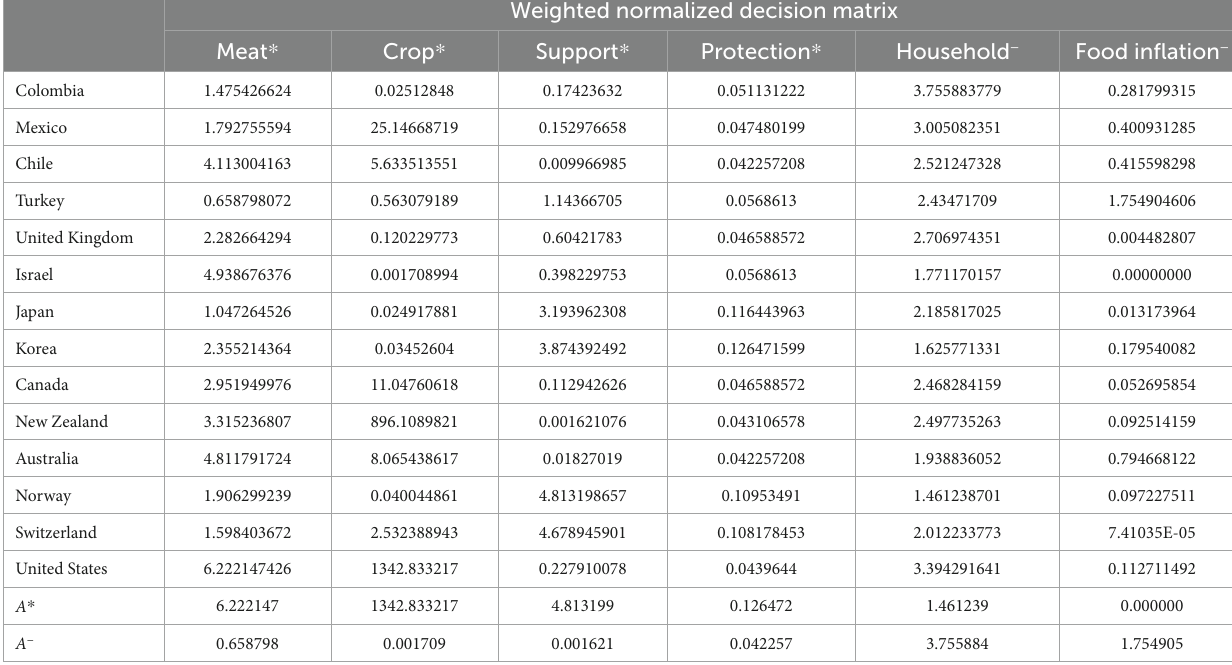
TABLE 7 Weighted normalized decision matrix with benefit (A * ) matrix and cost (A − ) matrix. Weighted normalized decision matrix